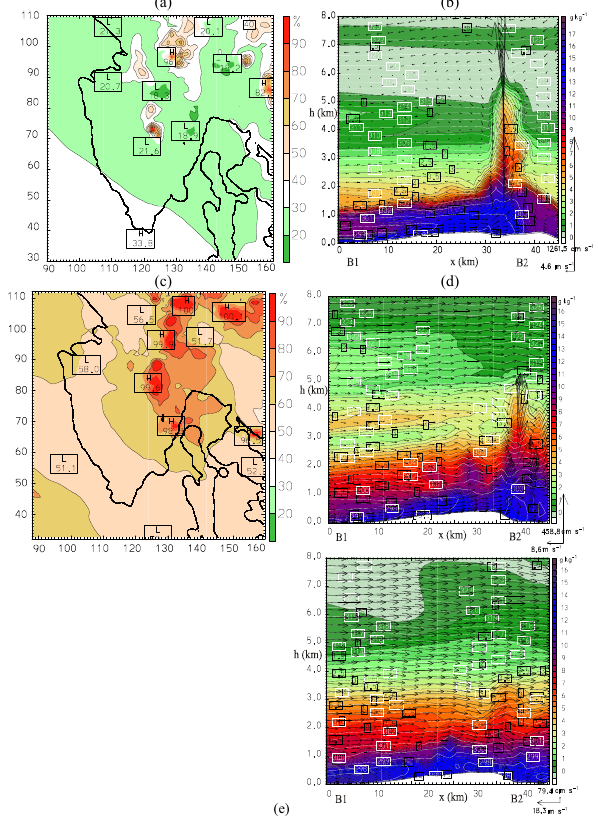
(e) 5 Figure 13. (a,c) Horizontal distributions of the averaged relative humidity (%) in the layer between 6 850 hPa and 500 hPa at 14 CET on (a) 8 June 2003 and (c) 6 July 2009; (b,d,e) vertical cross-sections 7 Fig. 13. (a, c) Horizontal distributions of the averaged relative hu- B1B2 (see in Fig. 1) of the potential temperature (while lines), humidity mixing ratio (filled areas) and 8 midity (%) in the layer between 850hPa and 500hPa at 14:00CET wind vectors at 13 CET on (b) 8 June 2003, (d) 6 July 2009 and (e) 7 July 2009. 9 on (a) 8 June 2003 and (c) 6 July 2009; (b, d, e) vertical cross- section (B1B2) (see in Fig. 1) of the potential temperature (white lines), humidity mixing ratio (filled areas) and wind vectors at 13:00CET on (b) 8 June 2003, (d) 6 July 2009 and (e) 7 July 2009.